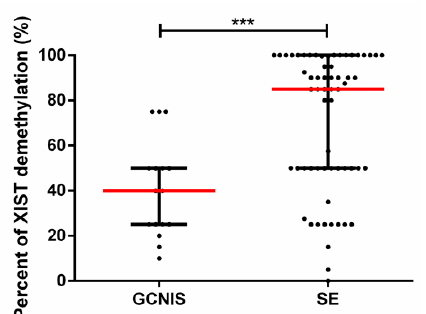
Figure 6. Demethylated XIST fragment percentage in germ cell neoplasia in situ (GCNIS) samples. Percentage of demethylated XIST fragment in GCNIS and seminoma. *** indicates p < 0.001 and ** indicates p < 0.01. Abbreviations: GCNIS—germ cell neoplasia in situ; SE—seminoma. Regarding (T)GCT cell lines, demethylated XIST was detected in all four cell lines. The percentage of demethylated XIST was significantly higher in NT2 as compared with the remaining cell lines (adjusted p -values of 0.0079, 0.0021, and 0.0108 as compared with TCam-2, NCCIT, and 2102Ep, NT2 cells showing three X chromosomes compared to two in 2102Ep and NCCIT.